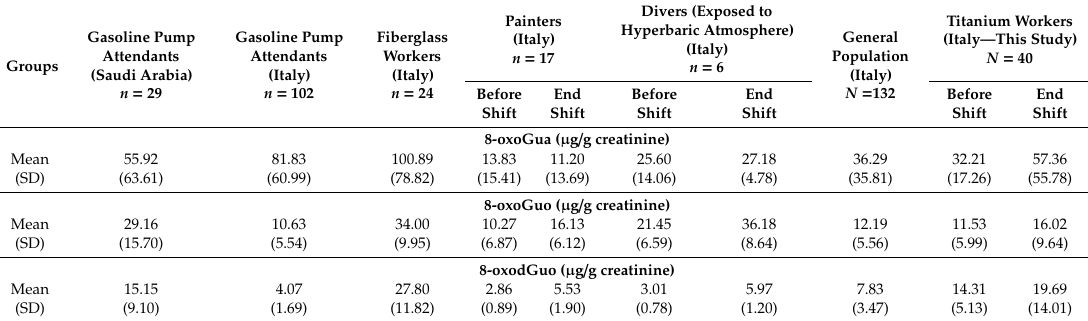
Table 4. Nucleic acids Oxidative stress levels in workers and general population subjects.